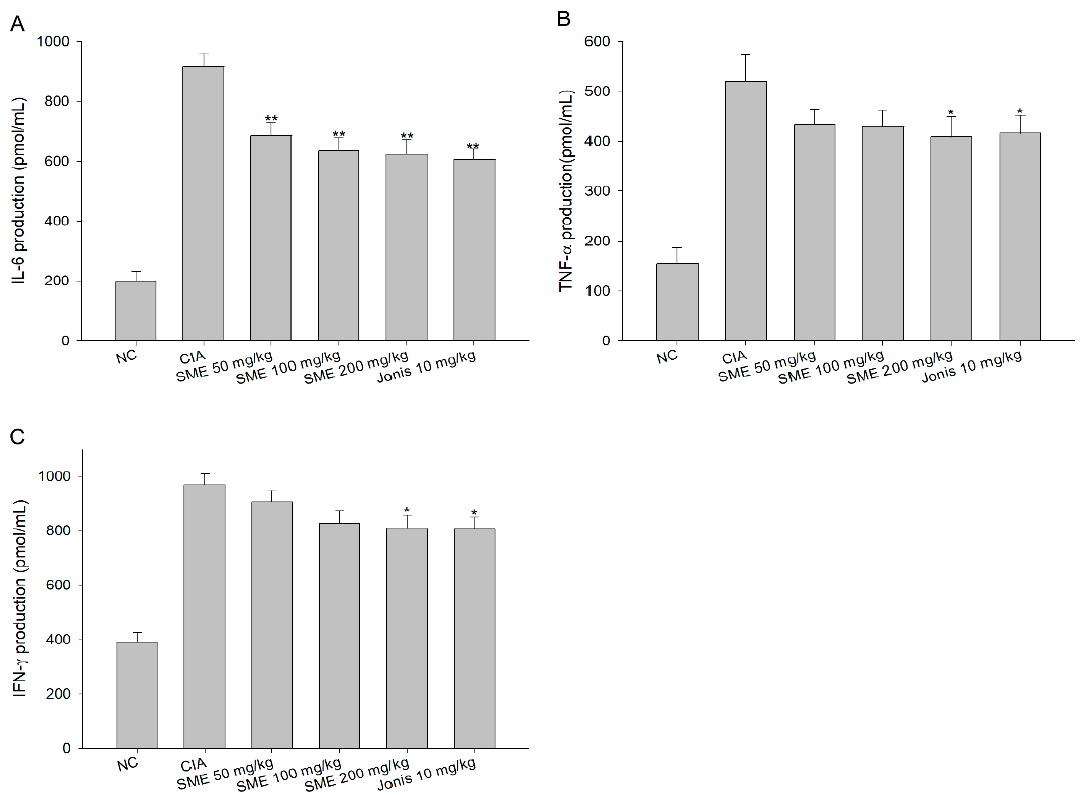
Figure 5. Effects of the Sargassum muticum extract on ( A ) IL-6, ( B ) TNF- α , and ( C ) IFN- γ production of lymphocytes. *: significantly different from the CIA group ( p < 0.05), **: significantly different from the CIA group ( p < 0.01).